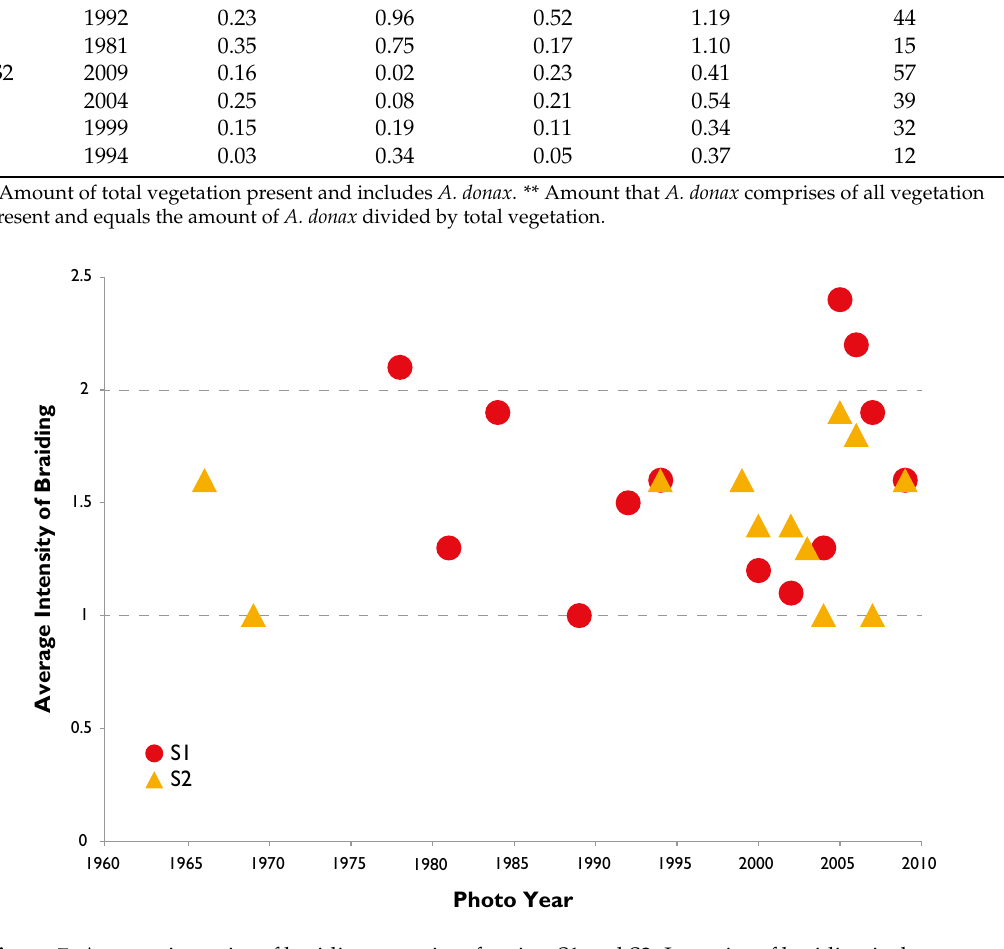
Figure 7. Average intensity of braiding over time for sites S1 and S2. Intensity of braiding is the mean number of channels measured from cross sections (see Figure 1) for a given reach. Dotted lines at y = 2.0 and 1.0 show a braiding envelope where most values lie between these points. High magnitude floods occurred at S1 in 1978, 1983, 2005, 2006 and S2 in 1969, 1998 and 2005.